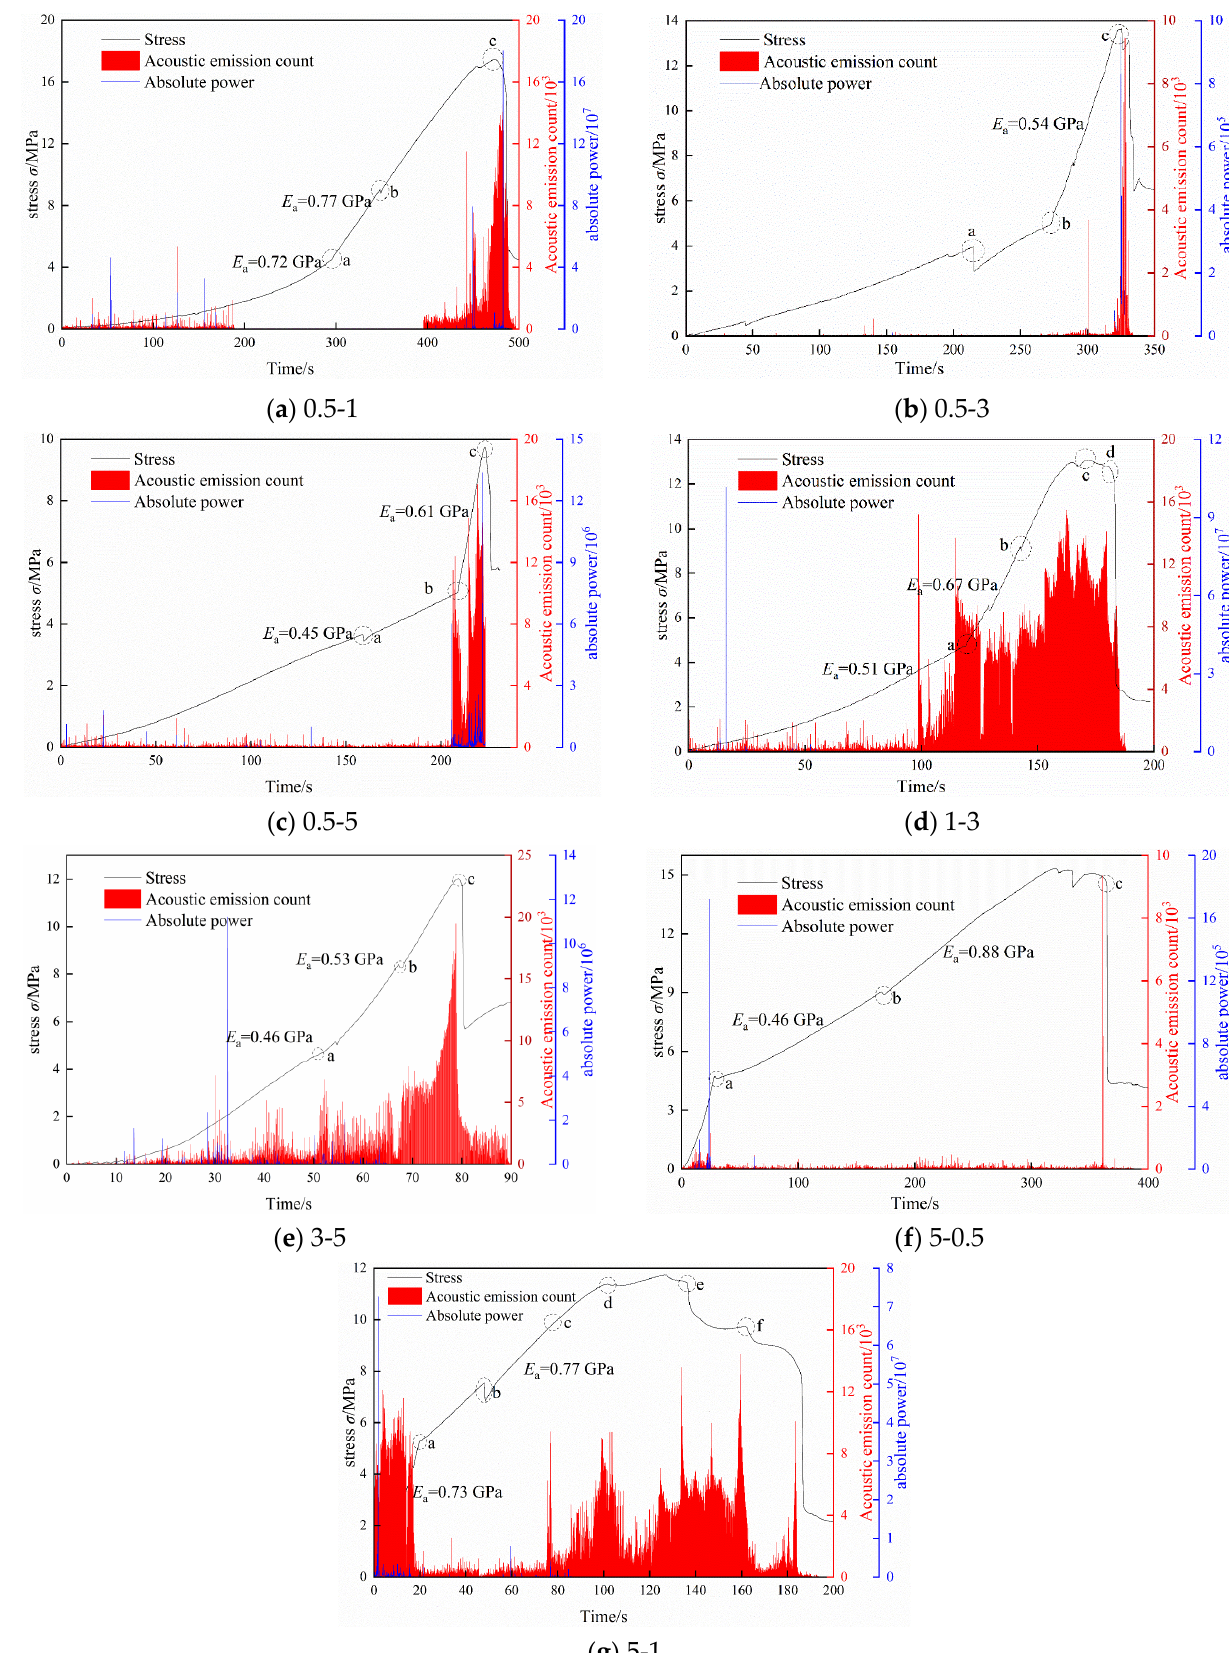
Figure 9. Acoustic emission characteristics of fractured rock samples.